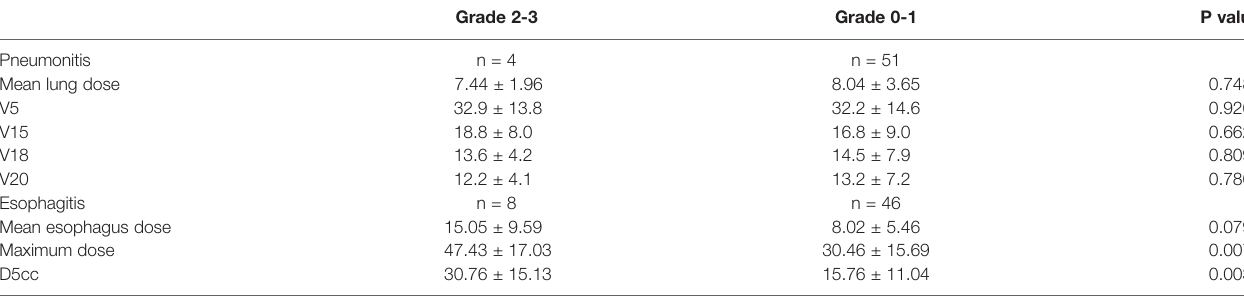
TABLE 3 | Dose statistics strati fi ed by toxicities grade. Grade 2-3 Grade 0-1 P value Pneumonitis n =